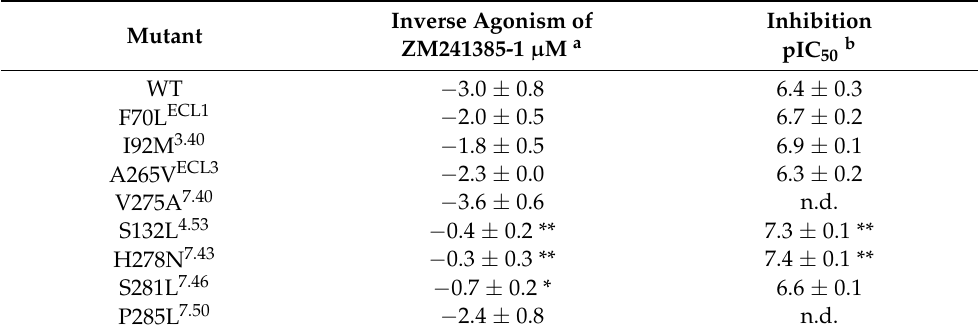
Table 3. Quantification of the inverse agonism of ZM241385 on A 2A ARs and the inhibitory potency of ZM241385 on NECA